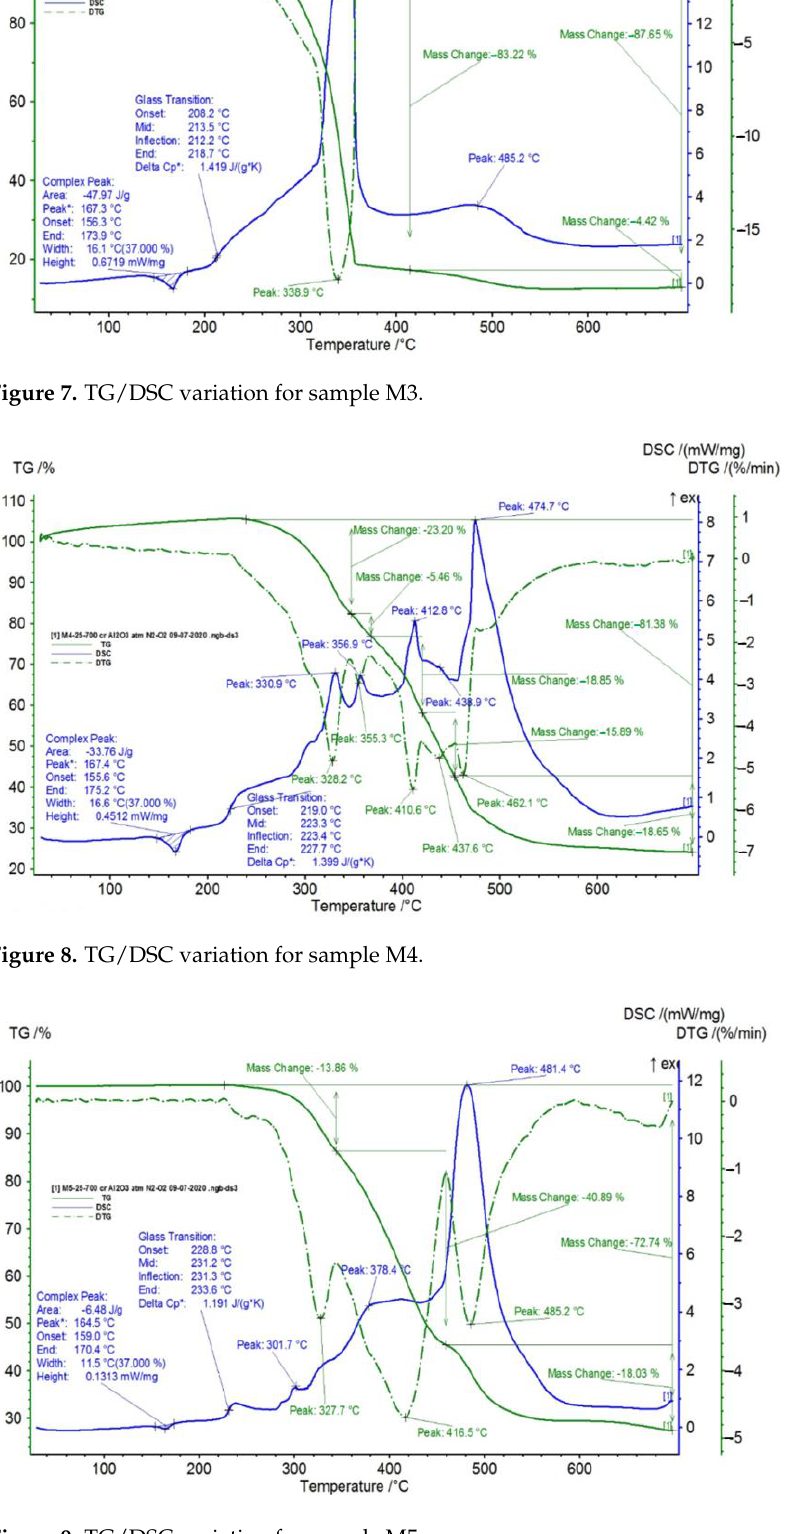
Figure 9. TG/DSC variation for sample M5.